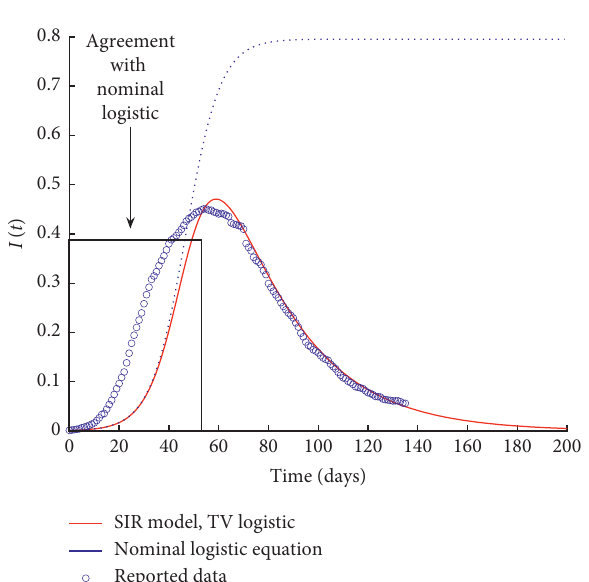
Figure 7: Comparison between the SIR model, the time-varying logistic equation, and the nominal one.